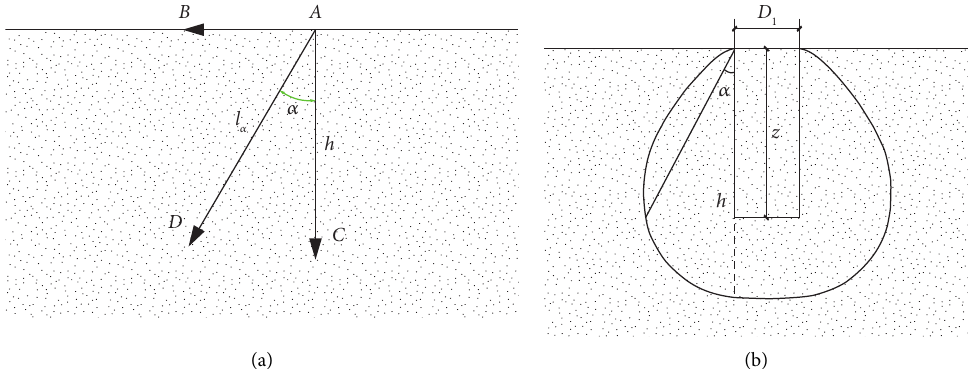
Figure 2: (a) Seepage length in different directions during period t . (b) Calculation diagram of soaked soil passing through the center of the